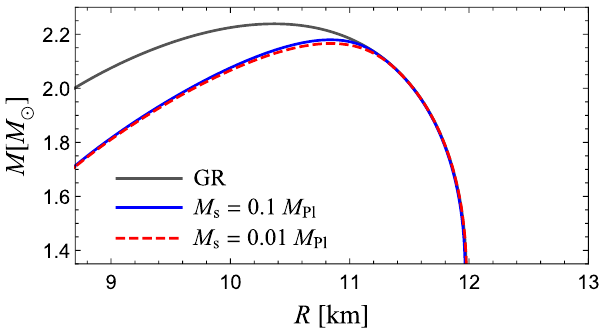
Figure 6. Mass versus radius diagram for equilibrium solutions with n = 0 in the regularized variant of the symmetron model, both for M s = 0.1 M Pl and M s = 0.01 M Pl . The corresponding GR diagram is also represented for